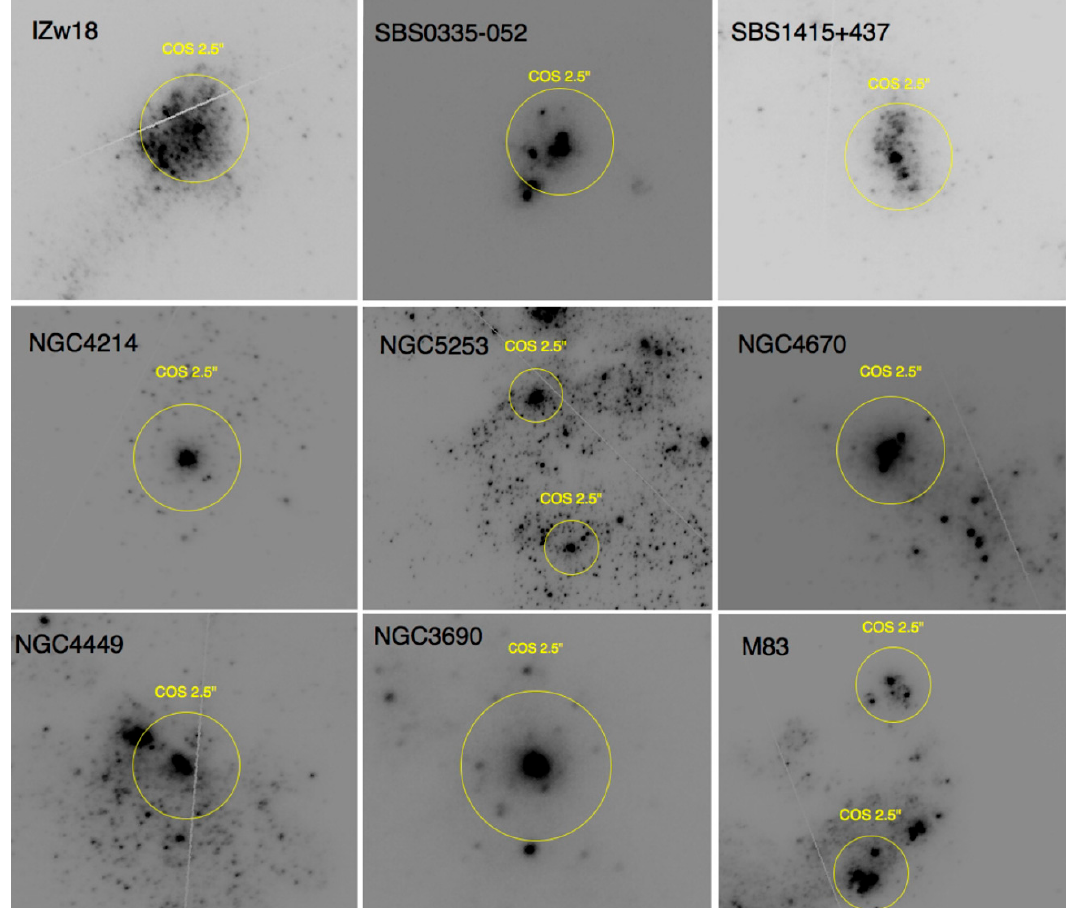
Figure 9. HST UV images of the star-forming galaxies hosting many massive young clusters. The overlaid circles indicate the 2.5” aperture of the HST Cosmic Origins Spectrograph ( COS ). The entrance aperture encompasses a single (NG 4214) or multiple clusters (e.g., I Zw 18). The linear diameter of the field enclosed by the aperture is (from left to right, top to bottom): 220 pc, 650 pc, 165 pc, 37 pc, 46 pc, 280 pc, 46 pc, 587 pc, 58 pc. From [32].